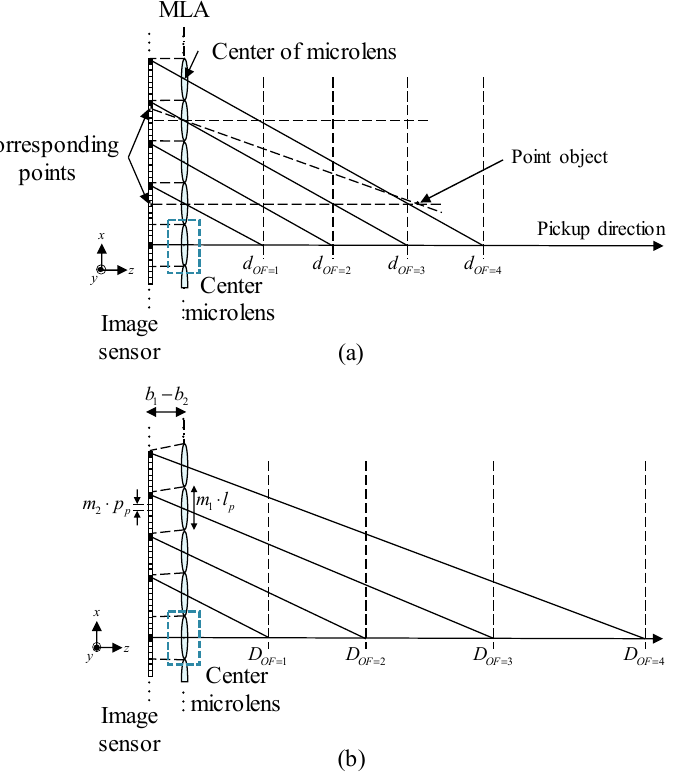
Figure 2. Depth extraction from captured light field using optical flow in ( a ) integral imaging and ( b ) light field camera.